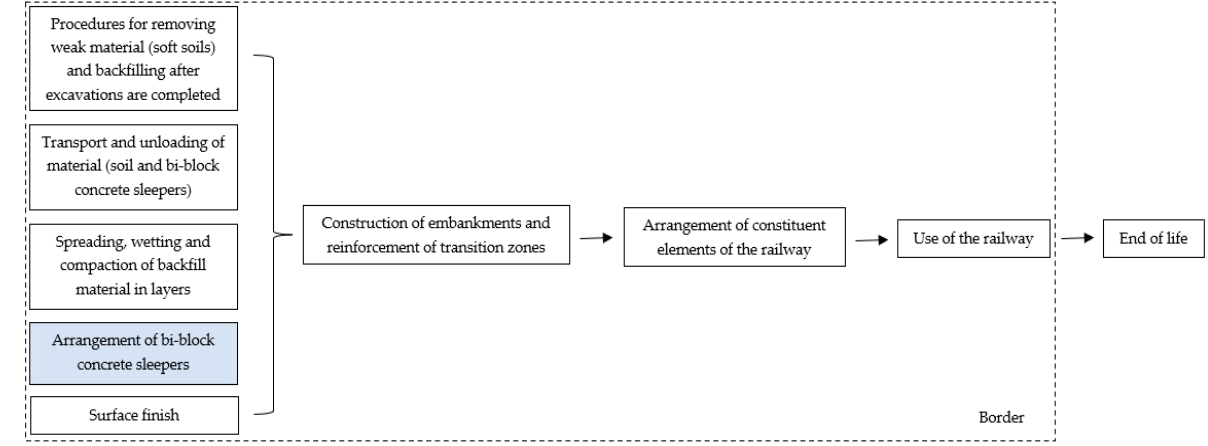
Figure 16. Processes considered in the environmental analysis of the different arrangements of BB sleepers and the study boundary.